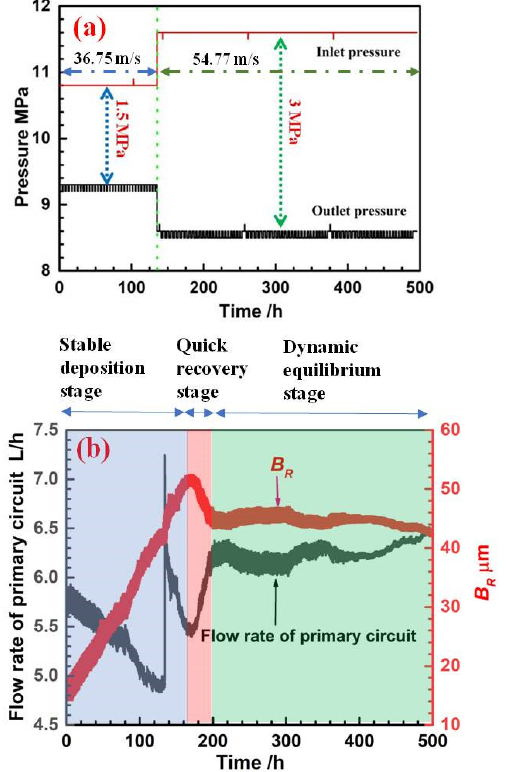
Figure 6. ( a ) The pressure evolution during the test. ( b ) The relationship between flow rate and radial build-up of the micro-orifice variation versus time.